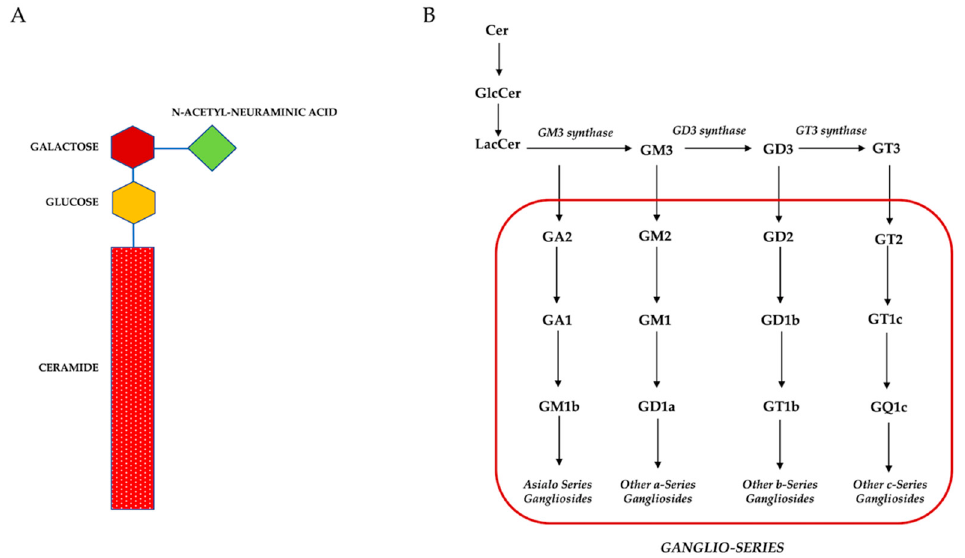
Figure 1. ( A ): Schematic representation of gangliosides structure (i.e., GM3). ( B ): Schematic representation of gangliosides metabolism.